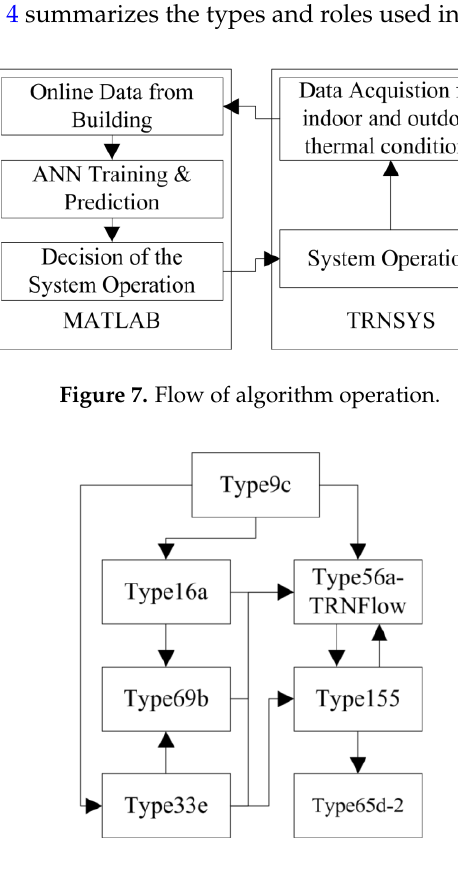
Figure 8. Components for modeling the test module and for data acquisition.